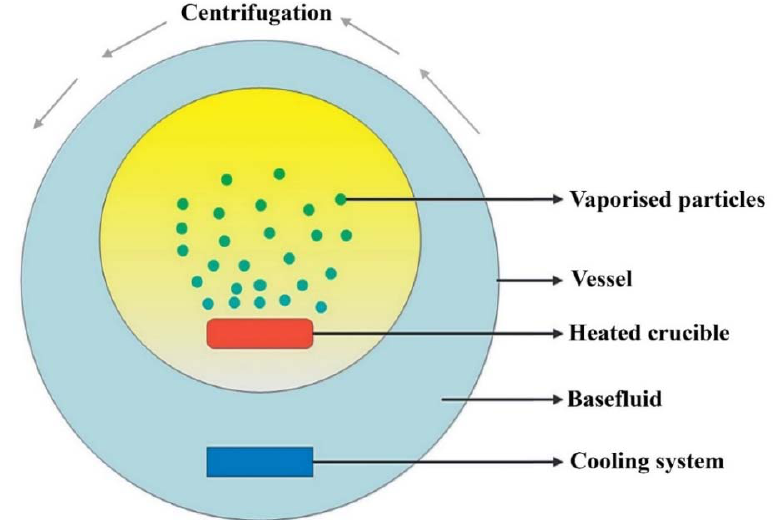
Figure 5. Eastman et al. one-step method for nanofluids fabrication. Reproduced with permission from [146]. Cambridge University Press, 2011.